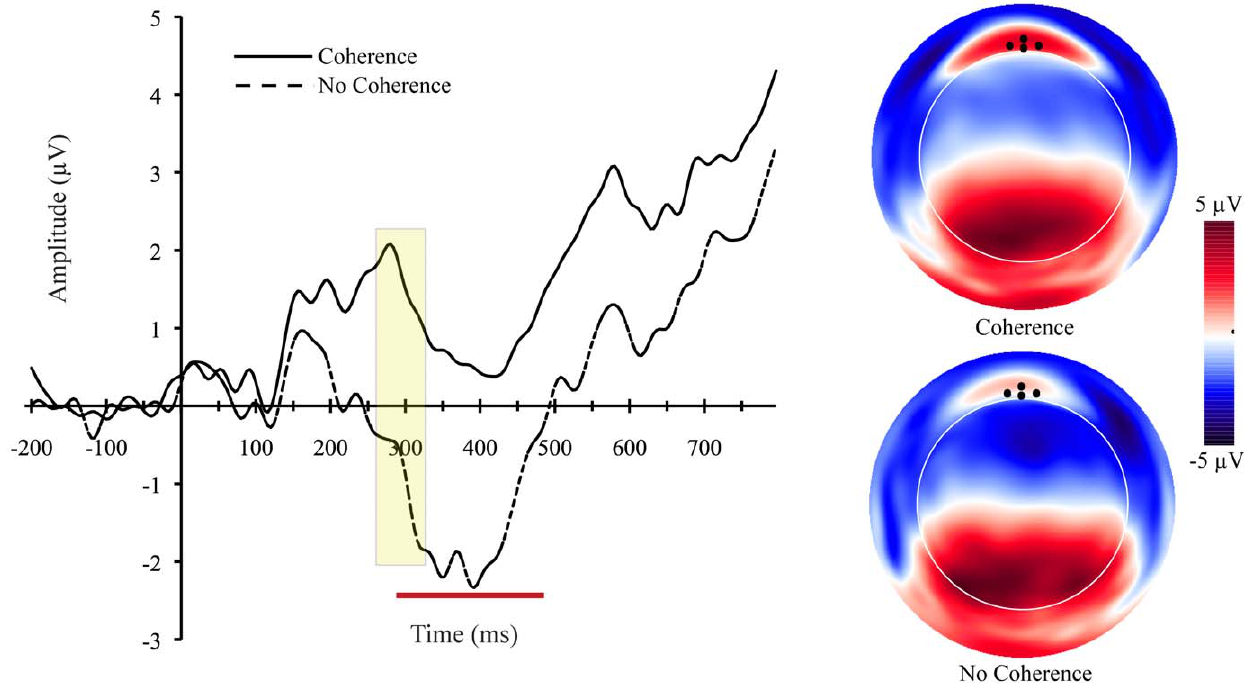
Figure 2. ERP waveforms and topographic maps. Left: Grand-average ERP waveform averaged across four frontal recording sites (indicated by black dots on the topographic maps on right). A ‘‘frontopolar P2’’ component is highlighted with yellow box and inversion of the P3 component is demarcated by red line. Right: Topographic maps at peak of P2. Black dots represent location of channels used to form the average waveforms. View of map is top looking down with nose towards top of image. Coherence = rated coherence for fragmented images; No Coherence = rated no coherence for scrambled images.